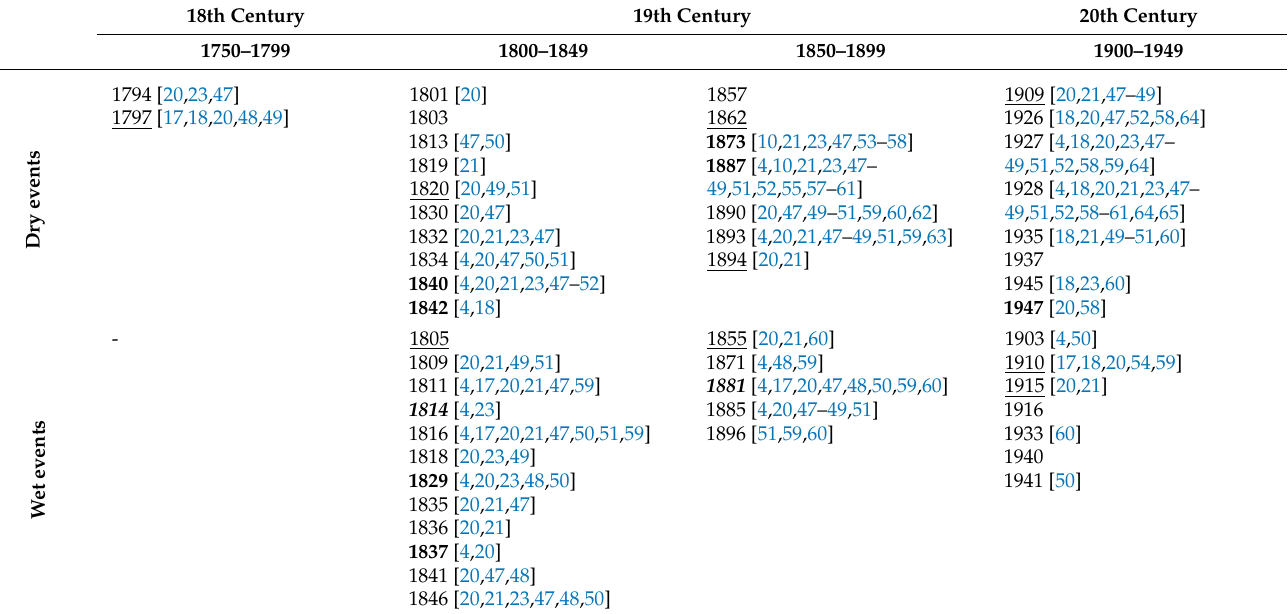
Table 5. The dry/drought and wet/flood years of P April-July /S April–August